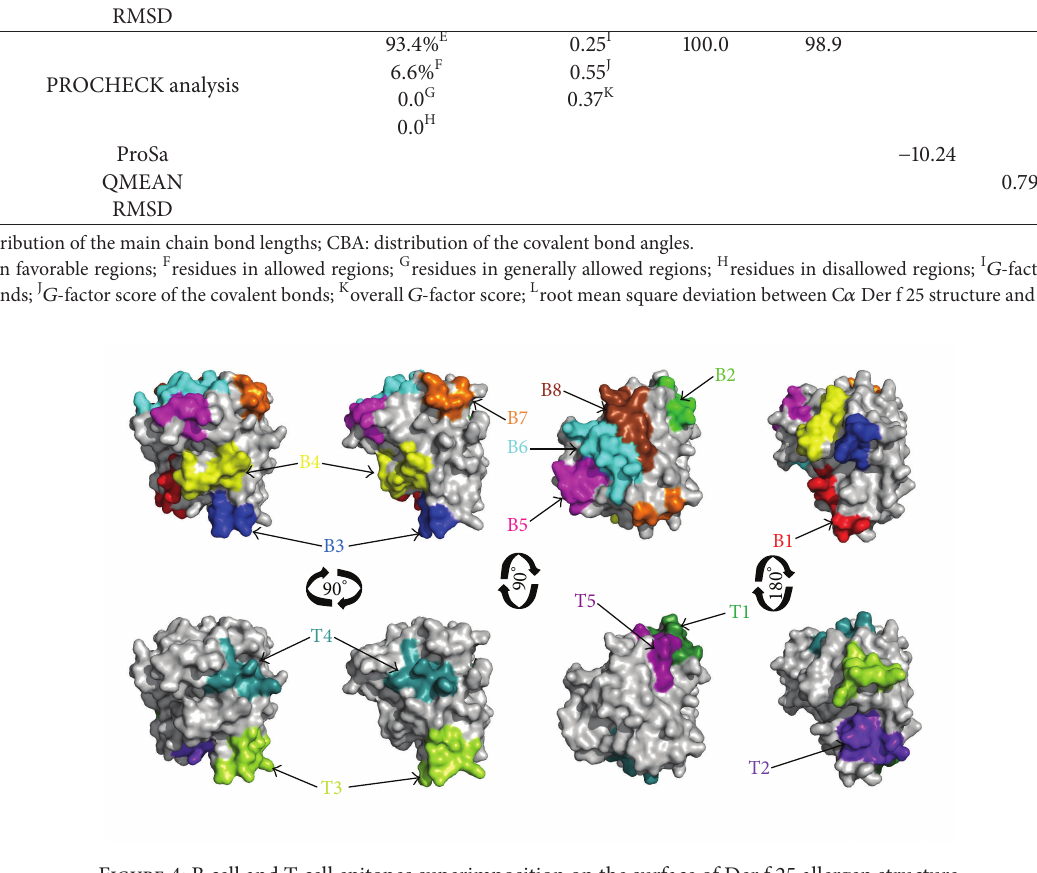
Figure 4: B cell and T cell epitopes superimposition on the surface of Der f 25 allergen